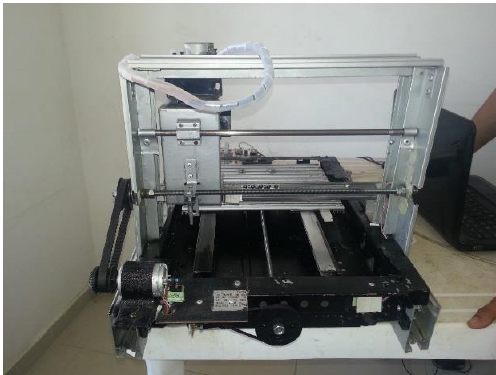
Figure 13. PCB drilling machine.